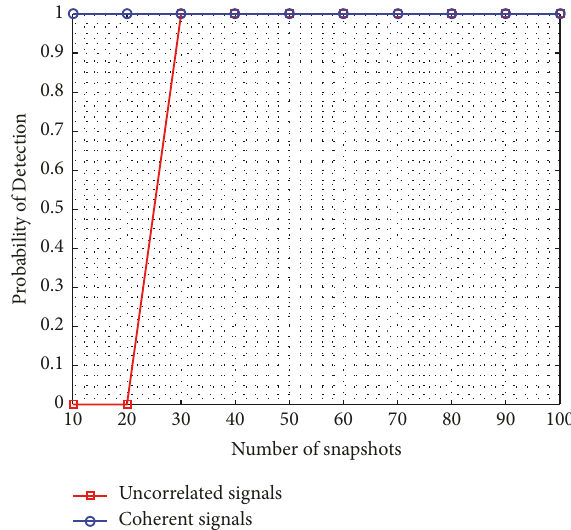
Figure 5: The detection probability versus the number of snapshots with SNR = 10